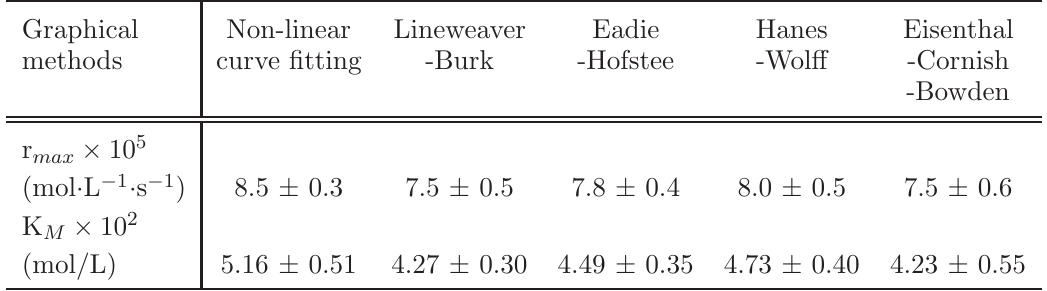
Table 1 Estimates of r max and K M from various graphical